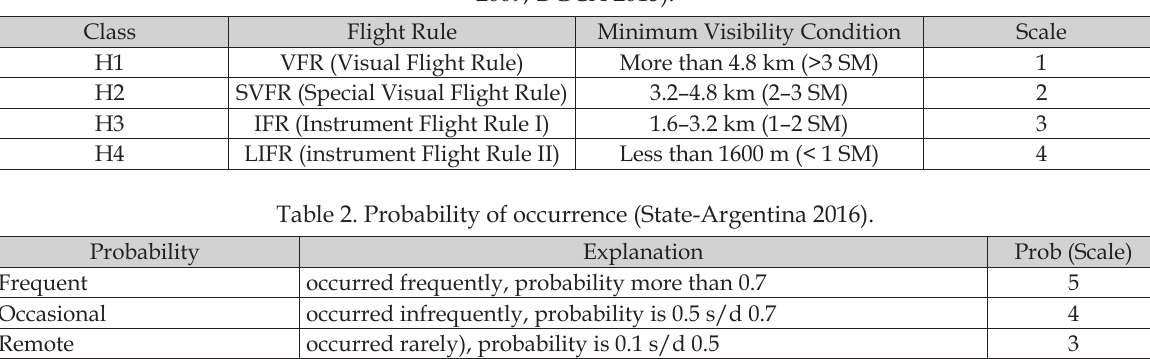
Table 1. Visibility below minima criteria for VFR and IFR (Glahn et al. 2015., Rudack, Ghirardelli 2010, FAA